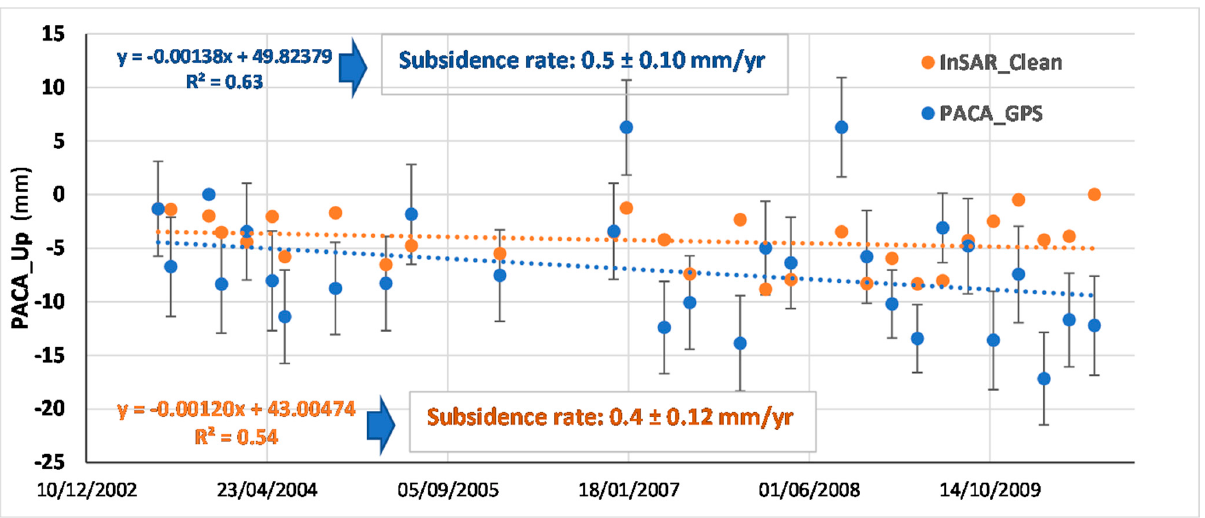
Figure 12. Comparison of GNSS and DInSAR time series (vertical component) collected in Palma Campania with the aim of validating the DInSAR data.